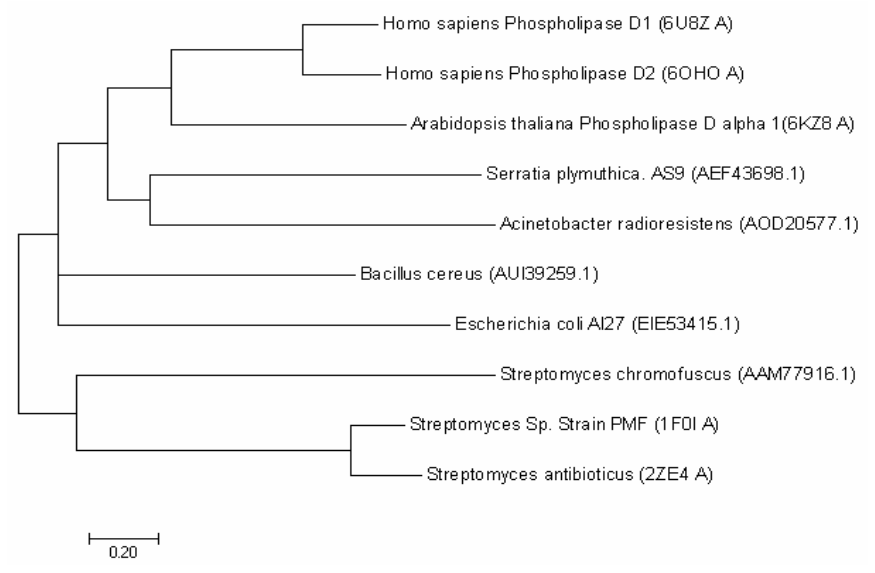
Figure 2. Phylogenetic analysis of SpPLD with other PLDs. Phylogenetic analysis with neighbor- joining (NJ) was conducted by using MEGA 7.0 software (Hachioji, Tokyo, Japan). Different PLD protein sequeces used for present analysis were shown in the bracket.